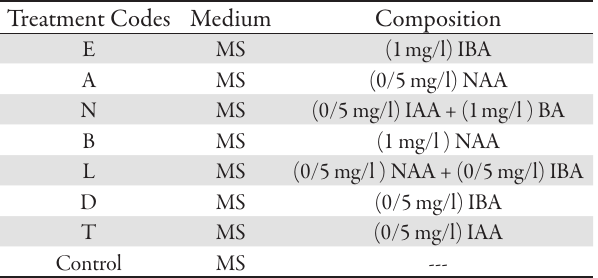
Tab. 1. Composition of PGRs used during rooting experiment Treatment Codes Medium